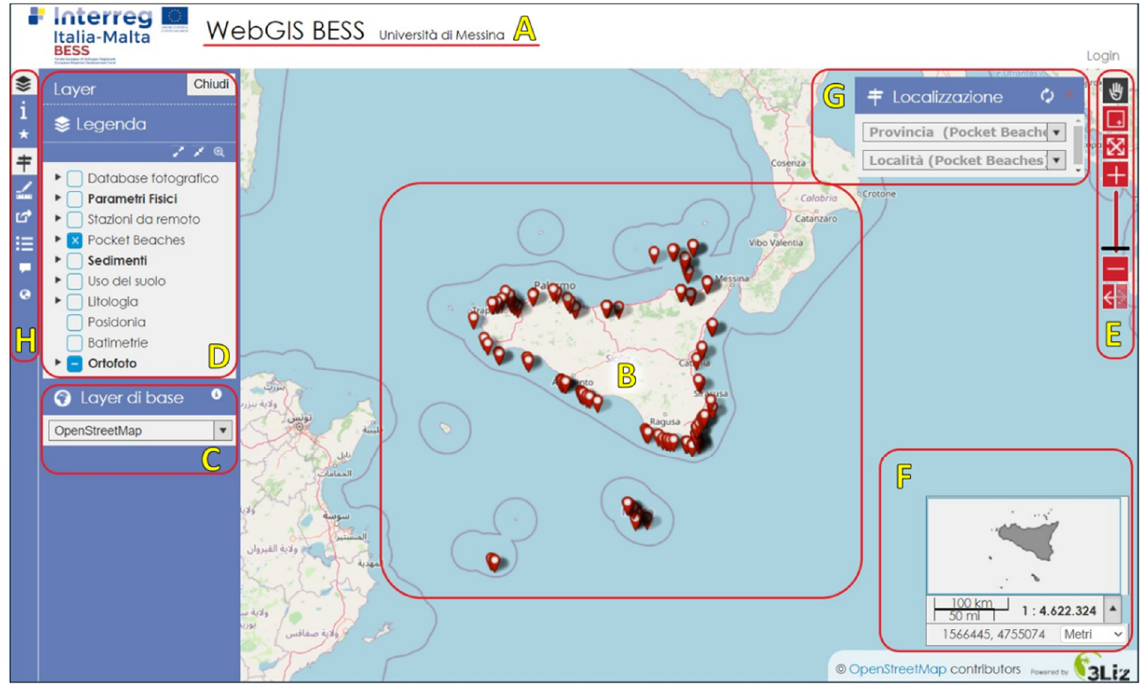
Figure 4. WebGIS home screen with yellow letters indicating the main default functions.